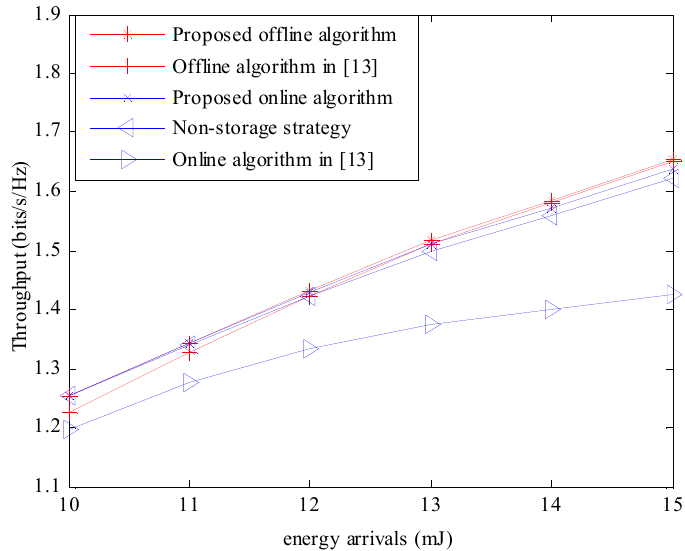
Figure 7. Throughput for the time-invariant channel with 60% storage efficiency.